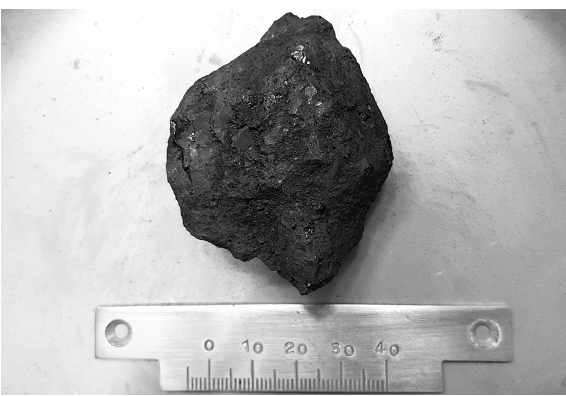
Figure 2: Block of Indonesian Coal subjected to swelling/shrinkage